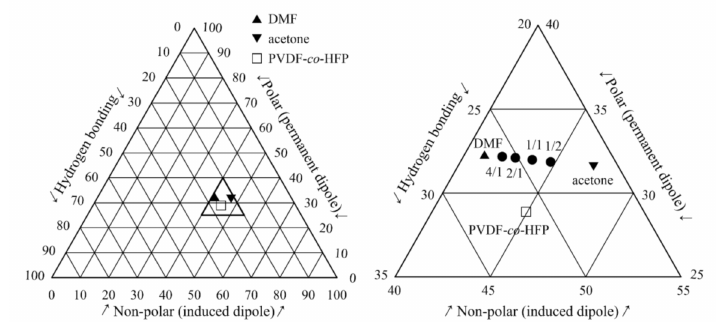
Figure 2. The Teas diagram relating locations of PVDF- co -HFP, DMF and acetone ( left ) and its magnification ( right ) also introduce the individual solvent